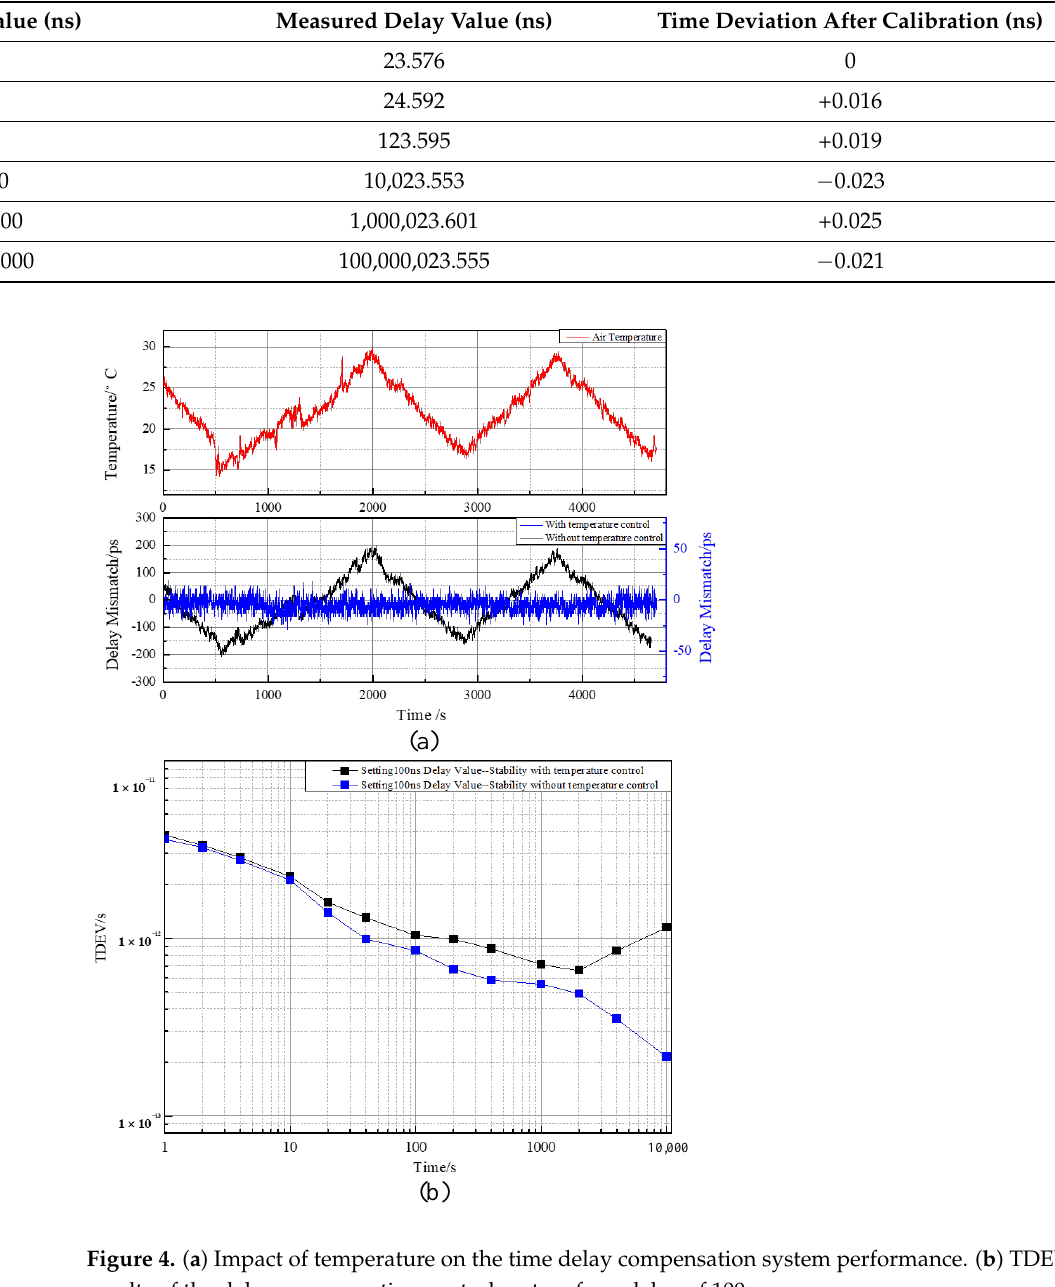
Table 1. Delay compensation control uncertainty results.